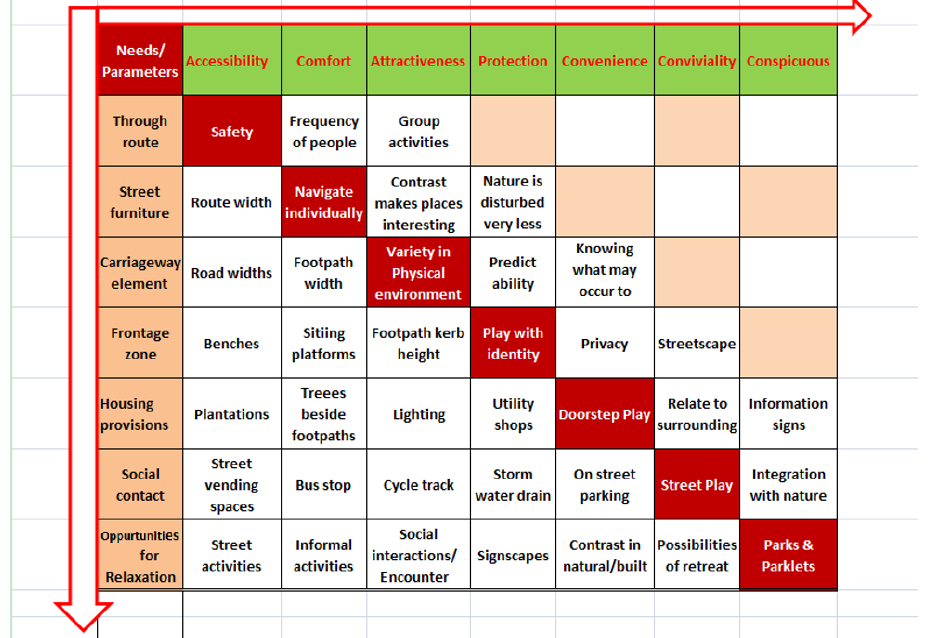
Figure 1. Matrix showing the children’s needs and